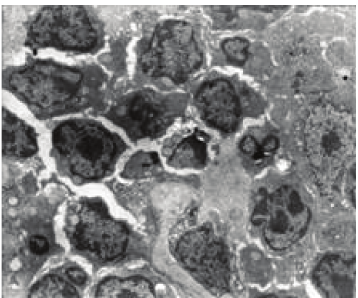
Figure 5: Treated group—12 hours in SAP experiment thymus (normal thymic lymphocyte and reticulate epithelium) Electron microscope ×